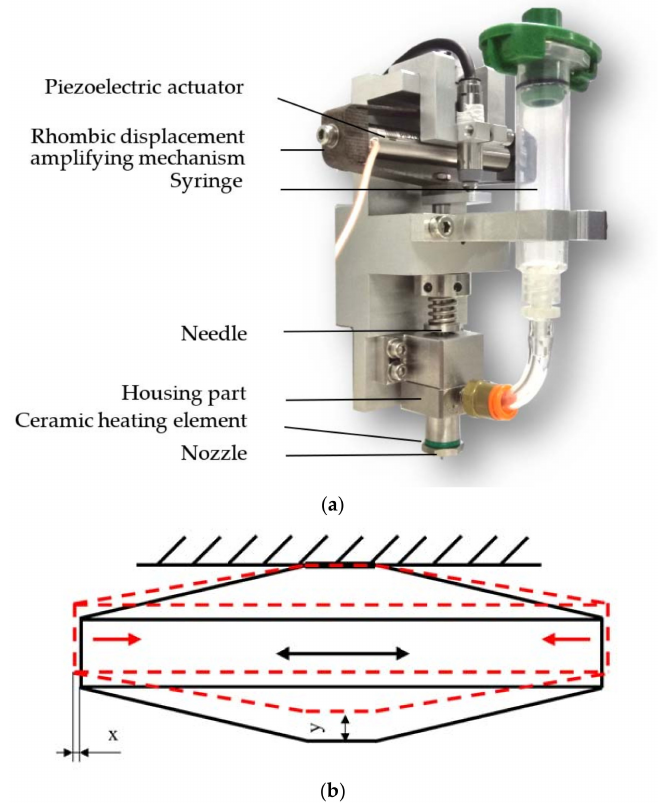
Figure 13. ( a ) Jetting dispenser; ( b ) Rhombic displacement amplifying mechanism; the black Figure is the state when the piezoelectric actuator is not energized, and the red figure is the state when the piezoelectric actuator is energized; “x” is half of the displacement produced by this piezoelectric actuator; “y” is the stroke of